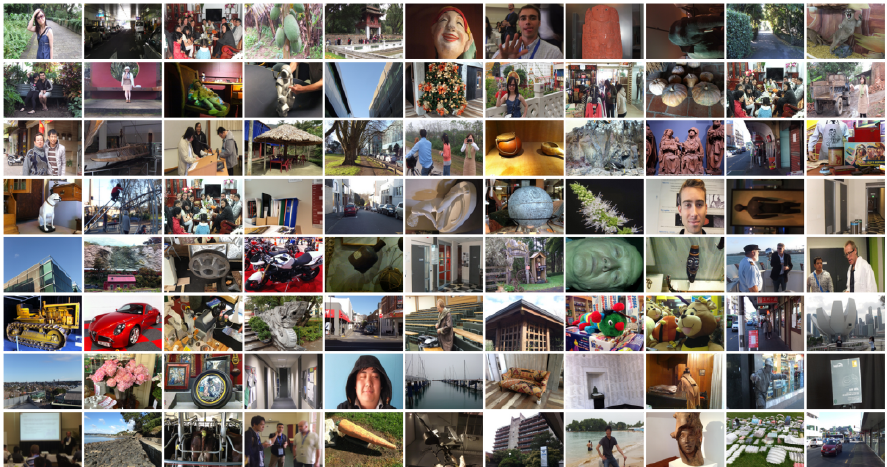
Figure 8. A portion of 200 pairs of real-life images are randomly selected from different categories for image feature point matching (only left images are